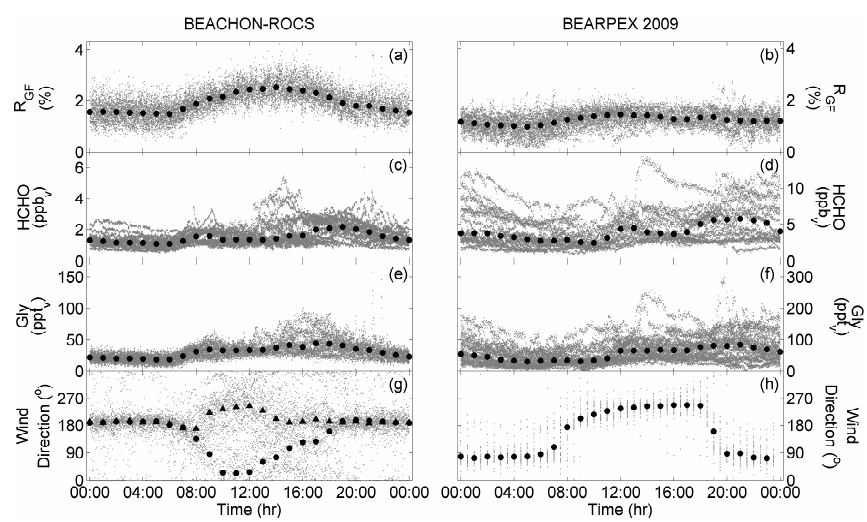
Fig. 1. Diurnal profiles of R GF , HCHO, Gly, and wind direction during BEACHON-ROCS and BEARPEX 2009. Grey dots represent individual ∼ 30s data points and black dots represent the 1h diurnal binned medians. Note that the Gly and HCHO y-axes are not the same between the two campaigns. The different symbols in the bottom left panel denote the two dominant diurnal wind profiles for that campaign, with triangles indicating the more dominant ( ∼ 60%) southwesterly wind direction and circles indicating the less dominant ( ∼ 40%) northeasterly wind direction. Table 1. Percent increases for Gly, HCHO, R GF , and other species for each transport event. Note that the values listed for R GF are the relative increases, not absolute changes in